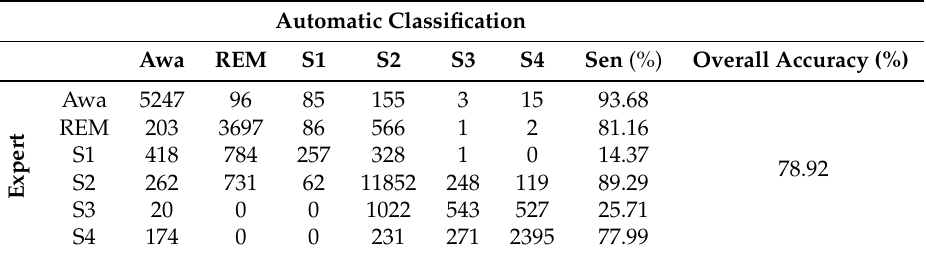
Table 20. The confusion matrix of six classes sleep state classification on DRMS database under the R&K standard. The l LE = 5, ω LE = db 4, n DSSM = 6, ω DSSM = db